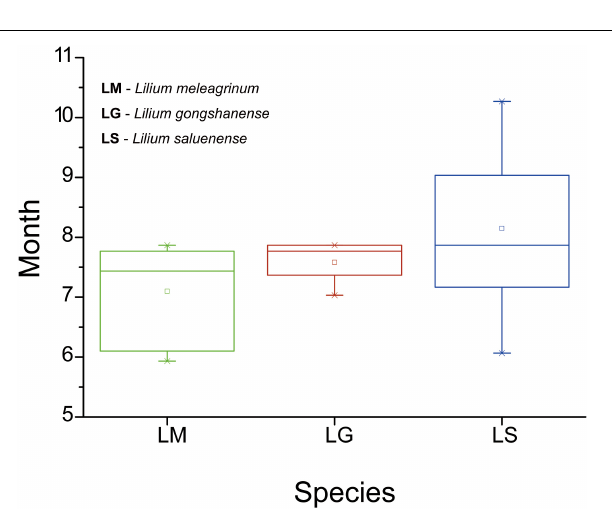
FIGURE 5 | Boxplots showing differences in flowering duration of the three species based on specimen records and field observations. LM, Lilium meleagrinum ; LG, L. gongshanensis ; LS, L. saluenense .